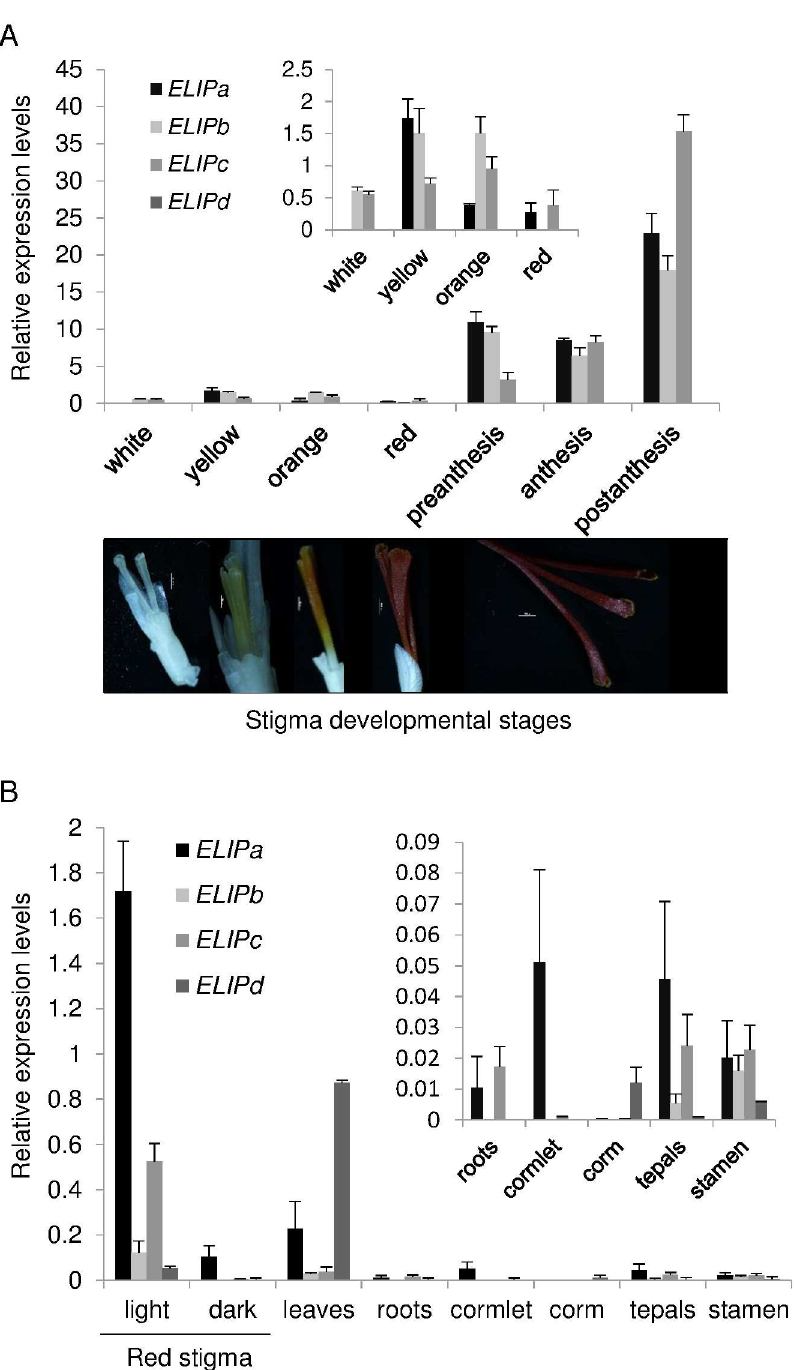
Fig 3. Expression analyses of ELIP genes isolated from saffron. (A) Relativeexpressionlevels of ELIPa- b duringthe development of the stigma in saffron. Inset are shown the relativeexpressionlevels of ELIPa-b in the early undevelopedstages of the stigma tissue. (B) Relativeexpressionlevels of ELIPa-b under two different light conditionsand in several saffron tissues. Inset are shown the expressionlevels of these genes in root, cormlet, corm, tepal and stamen. Error bars depict SD. Below are shown the pictures of stigmas at different developmental stages: white, yellow, orange, red and stigmas at